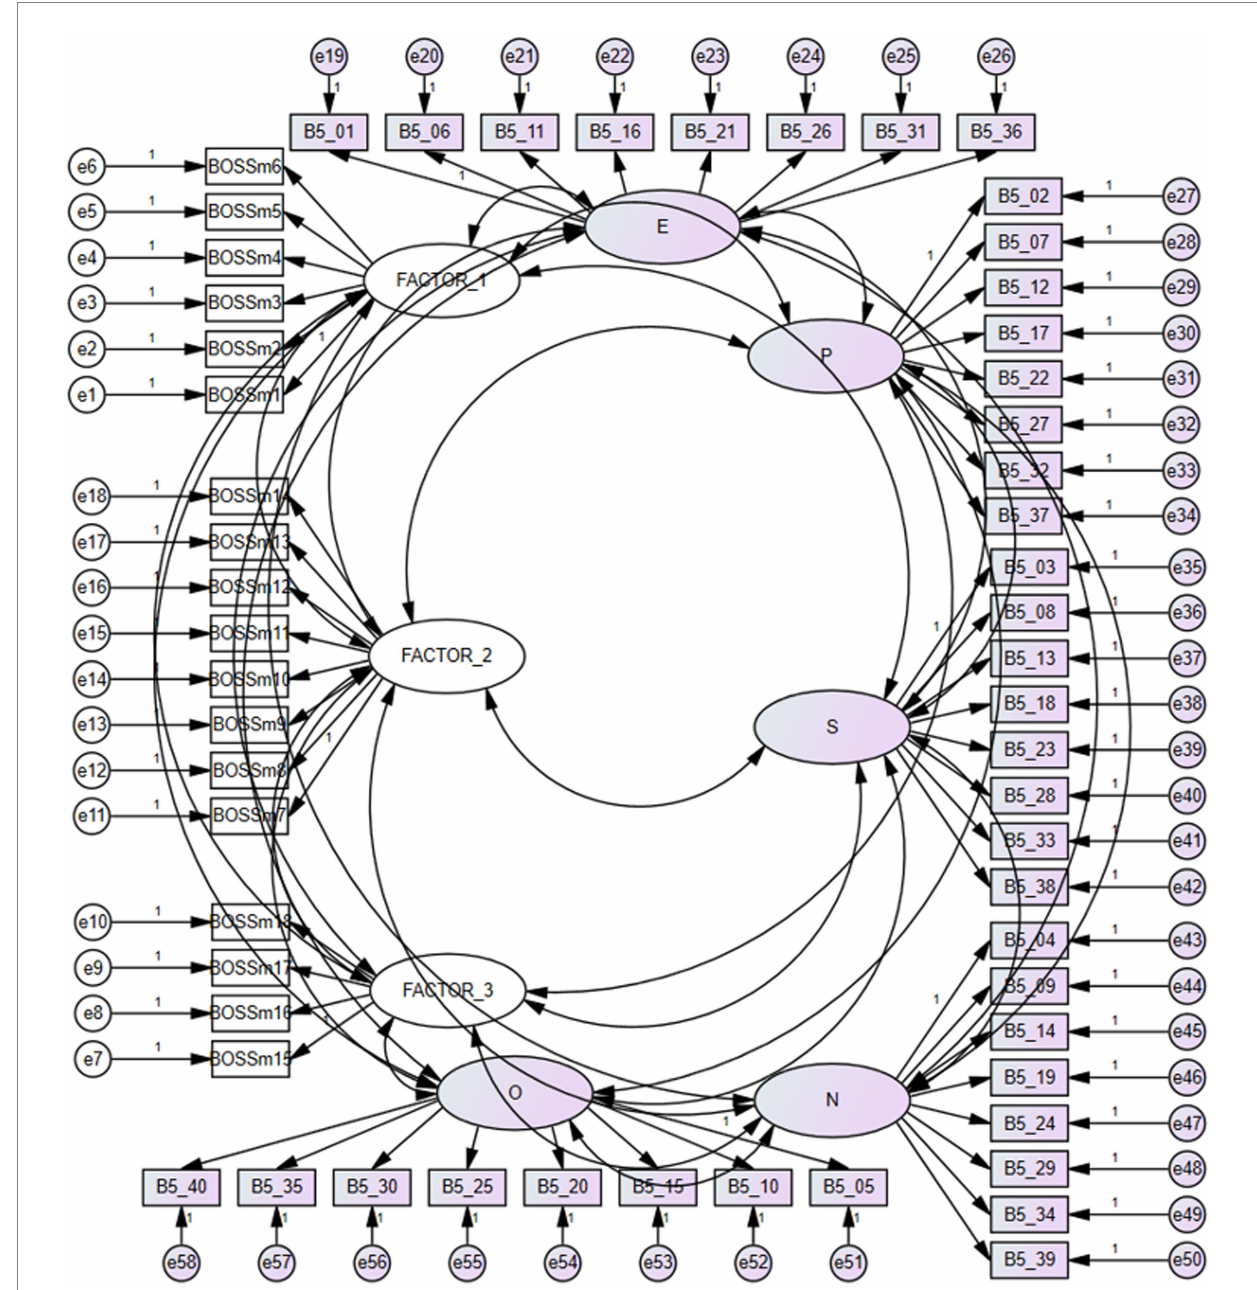
FIGURE 1 The theoretical model of the links between BOSSm18 and B5FACTOR_1 = CAB (BOSSm18), FACTOR_2 = PAB (BOSSm18), FACTOR_3 = WAB (BOSSm18). E, extraversion (B5); P, agreeableness (B5); S, conscientiousness (B5); N, neuroticism (B5); O, openness